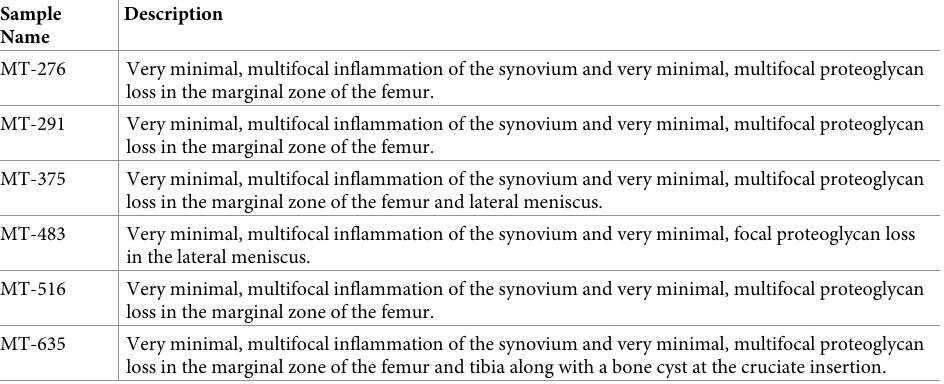
Table 2. The qualitative results of the histological evaluations on individual animals. MT- 276 (right knee joint) and MT-291 (left knee joint) are from a single na ï ve rat. MT-375 and MT-516 are right knee joints injected with EGCG, and MT-483 and MT-635 are control saline-injected left knee joints from two